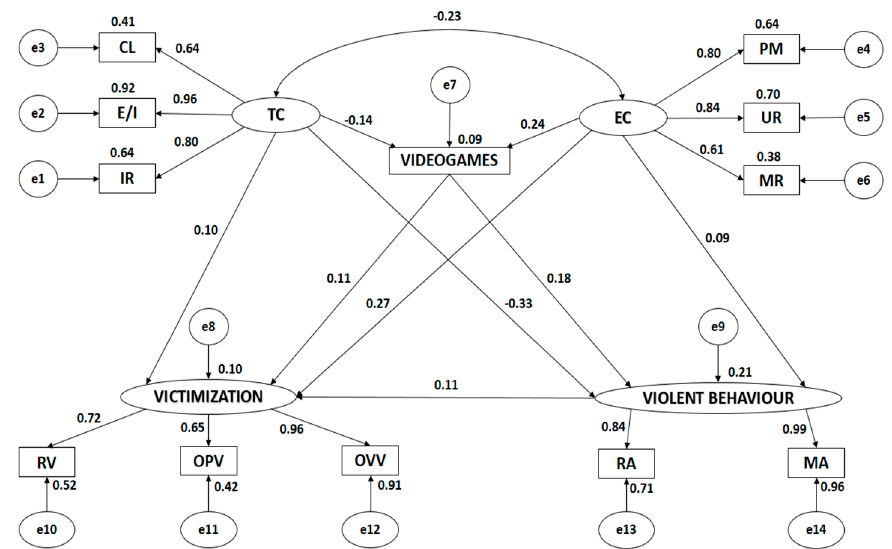
Figure 3. Structural equation model in sedentary subjects. Note: TC, task climate; CL, cooperative learning; E/I, effort/improvement; IR, important role; EC, ego climate; ITR, intra-team rivalry; PM, punishment of mistakes; UR, unequal recognition; VIDEOGAMES, use of videogames; VICTIMISATION, victimisation; RV, relational victimisation; OPV, overt physical victimisation; OVV, overt verbal victimisation; VIOLENT BEHAVIOUR, violent behaviour; MA, manifest aggressiveness; RA, relational aggressiveness. Table 2 . Structural model in sedentary subjects.